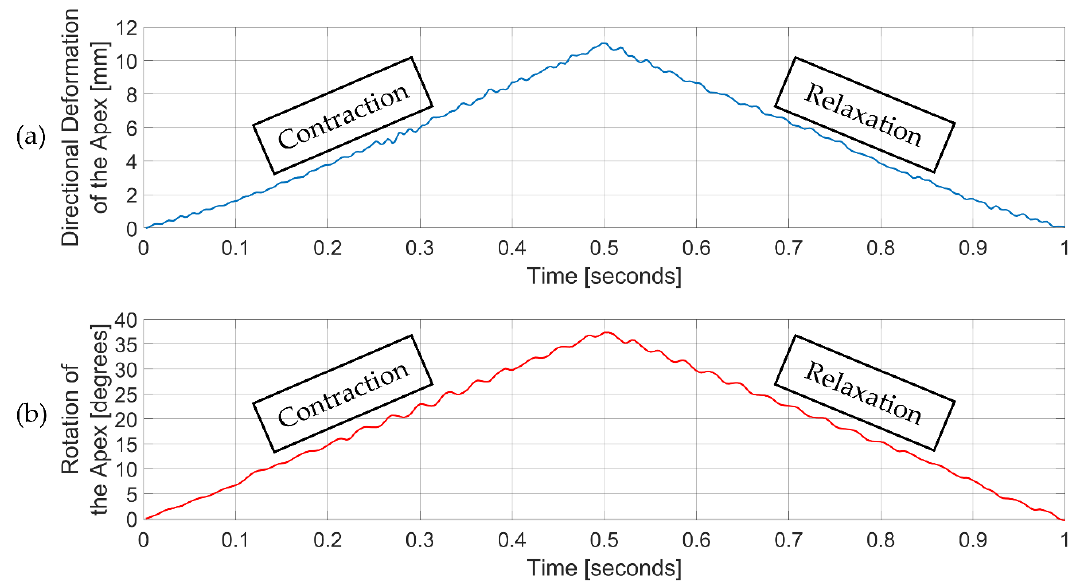
Figure 8. Time change of directional deformation and rotation of the apex over one beating. Actuators were loaded from 0 to 0.5 s and unloaded from 0.5 s to 1 s. ( a ) Directional deformation of the apex; ( b ) Rotation of the apex.